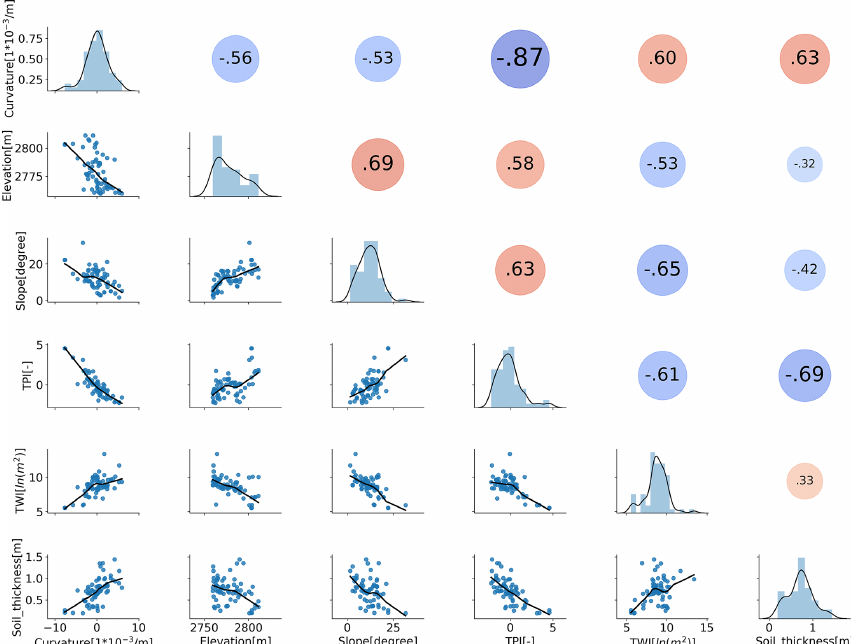
Figure 5. Correlation analysis between soil thickness and the top five most highly correlated topographic features. TPI is 10m resolu- tion topographic position index, curvature is 10m resolution curvature, slope is 10m resolution slope degree, TWI is the 10m resolution topographic wetness index, and elevation is the 1m resolution DEM.